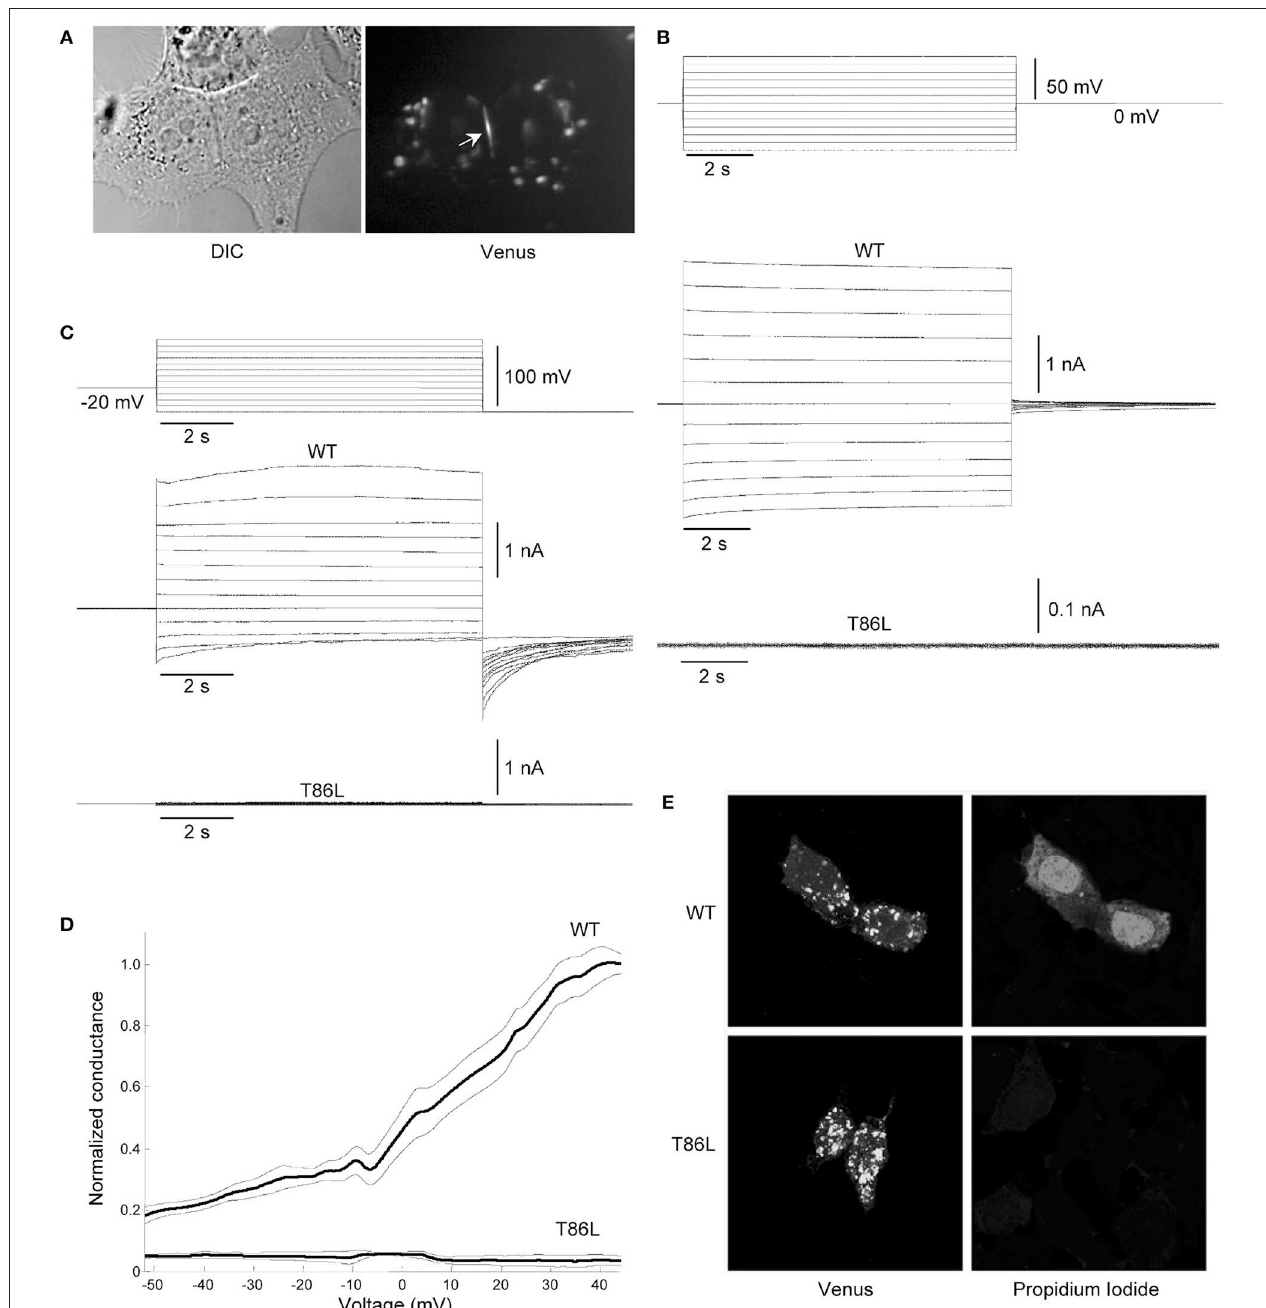
FIGURE 8 | Patch clamp and dye-uptake assays in HeLa DH transfectants . (A) Left: differential contrast image (DIC) of HeLa DH cells transiently transfected with hCx26T86L fused in frame with the GFP color mutant Venus; right: same field of view under fluorescence illumination, highlighting a gap junction plaque between a pair of adjacent cells (arrow). Cytosolic fluorescent puncta are consistent with previous analysis of connexin trafficking en route to the plasma membrane (Thomas et al., 2005). (B) Voltage commands applied to cell 1 (top traces) elicited junctional currents in the adjacent cell (cell 2) of a pair of HeLa DH cells transiently trasfected with wild type (WT) hCx26 (middle traces); junctional currents were undetectable in T86L transfectants (bottom traces). (C) Representative measurements of hemichannel currents elicited by voltage commands (top traces) in HeLa DH cells transiently trasfected with wild type (WT) hCx26 (middle traces); hemichannel currents were undetectable in T86L transfectants (bottom traces). (D) Membrane conductance in response to slow (400s) voltage ramps from nominal + 60 to − 60mV; ordinates were normalized by the mean conductance of WT hCx26 at + 40mV; abscissas were corrected for the voltage drop due to the access resistance (18 ± 3 MOhm for T86L, n = 6; 19 ± 5 MOhm for WT, n = 6); measurements in (B,C) were performed in 0.2mM extracellular Ca 2 + . (E) Incubating HeLa DH cells for 60min in nominally Ca 2 + -free extracellular solution containing Propidium Iodide 0.25mM promoted dye uptake in cells expressing WT hCx26 (top), whereas cells expressing the T86L mutant failed to uptake the dye